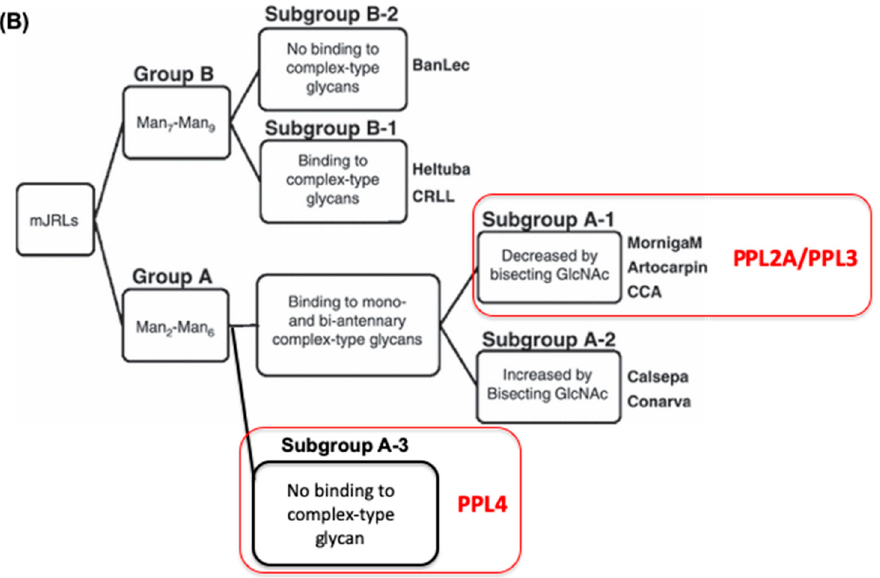
Figure 5. Bar graph representation of the relative affinity (%) of PPL2A, PPL3s, and PPL4 with another eight mJRLs towards selected N-linked glycans ( A ) and classification of mJRLs by sugar-binding specificities ( B ). Data for Conarva, Calcepa, MornigaM, CCA, Artocarpin, Heltuba, CRLL, and BanLec are cited from Nakamura-Tsuruta et al. (2008) [33]. The numbers on the left correspond to the numbers of selected glycans listed in Supplementary Materials Figure S6. Groups A (A-1, A-2) and B (B-1, B-2) show the classification of mJRLs based on FAC analysis.